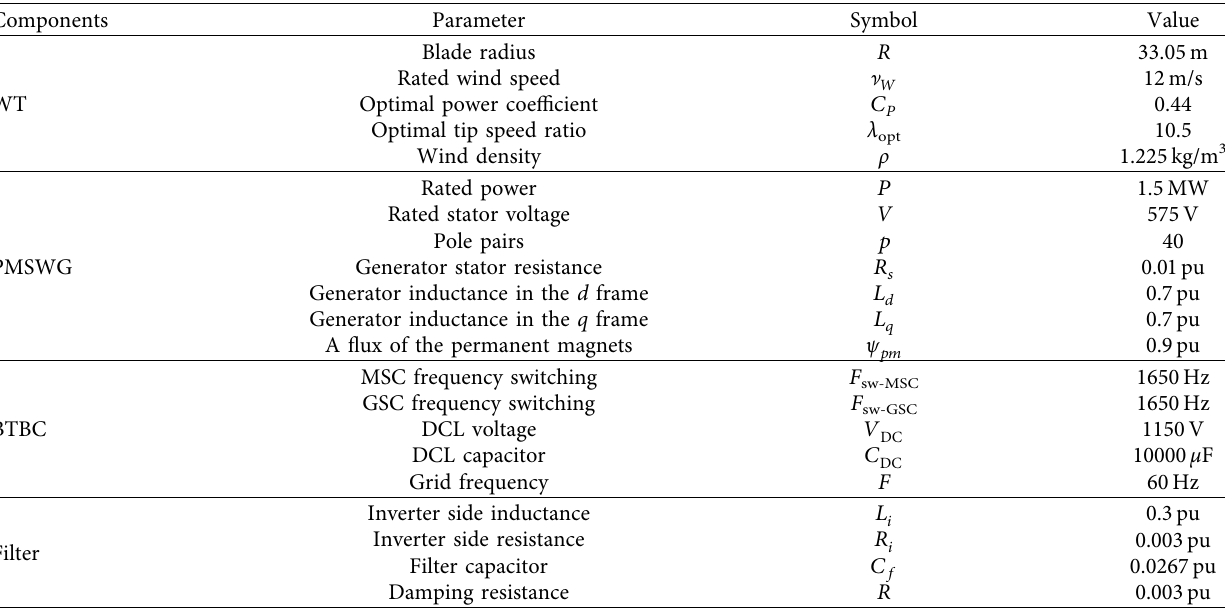
Table 8: Simulated PMSWG parameters [6, 20].